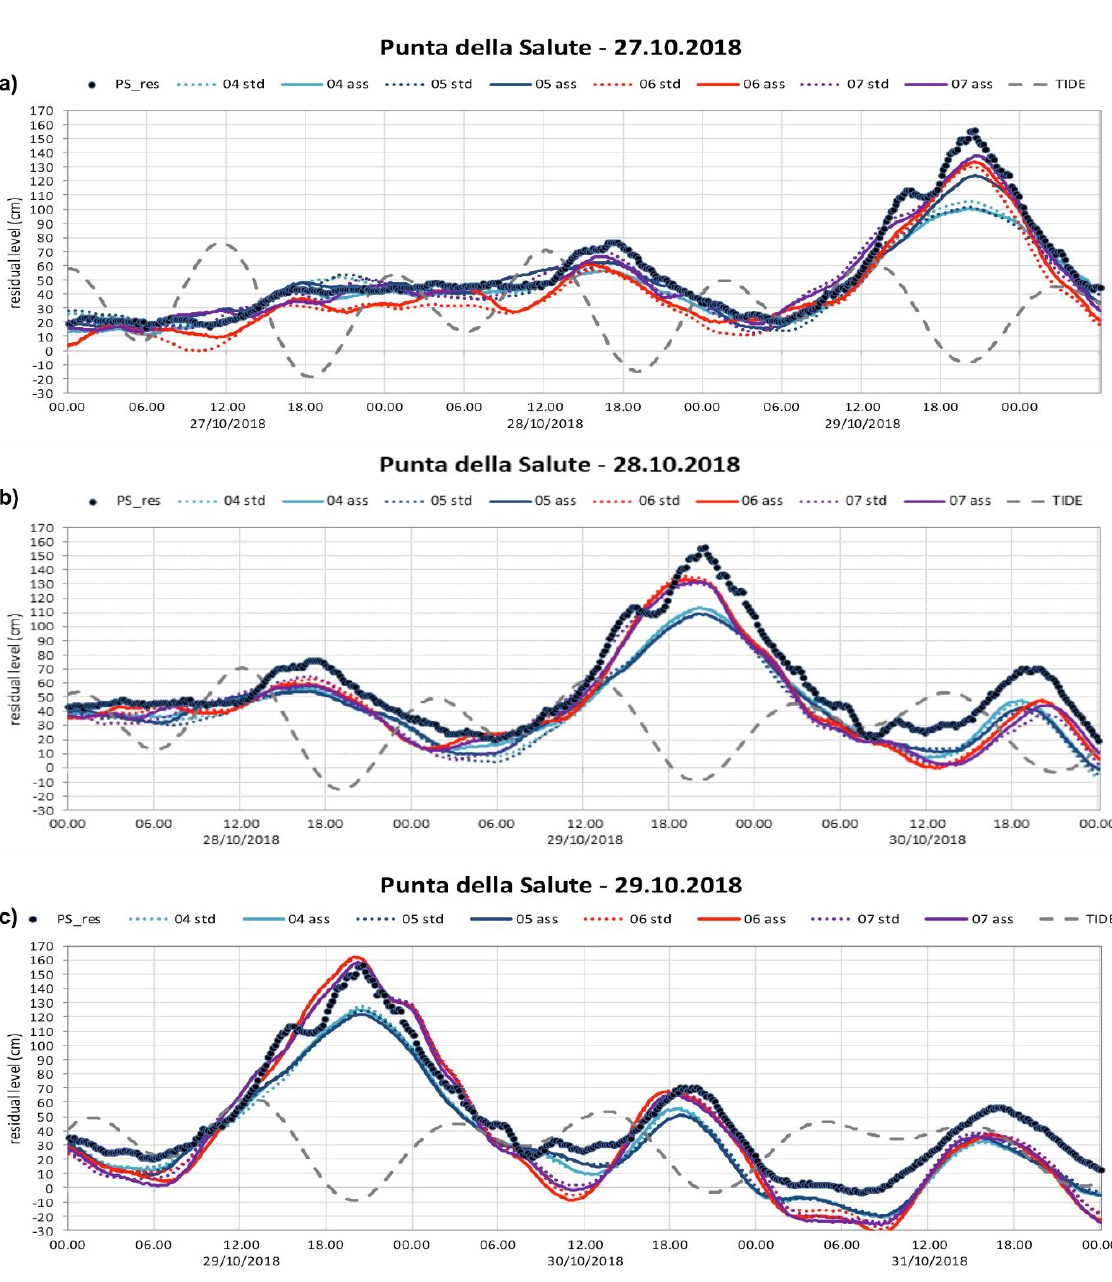
Figure 8. Forecast of the storm event – 29 October 2018 (“Vaia Storm”). Results are shown from various versions of the model running at ISPRA. The observed residual is given with black dots. (a) Forecast 3d before the event, (b) 2d and (c)